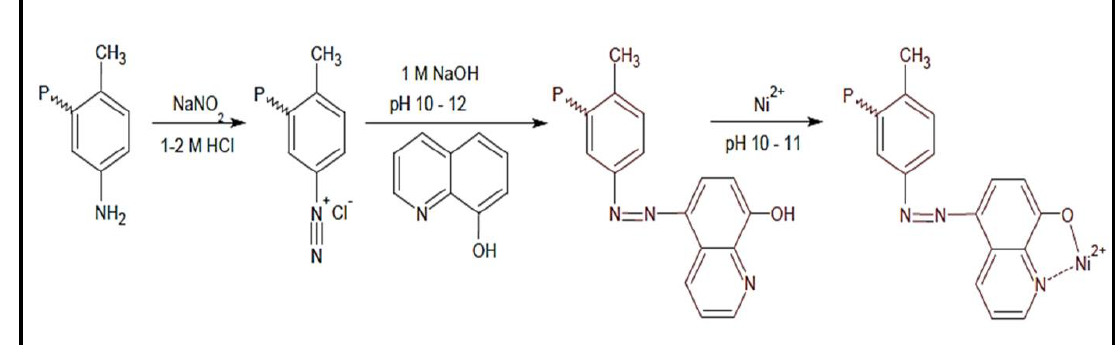
Figure 1. The scheme of chemical modification of PUF sorbent PUF diazotization was carried out as follows. 30 mL 1 M HCl and 200  g PUF sorbent were placed in a glass vessel for extraction lapped cover. PUF tablet